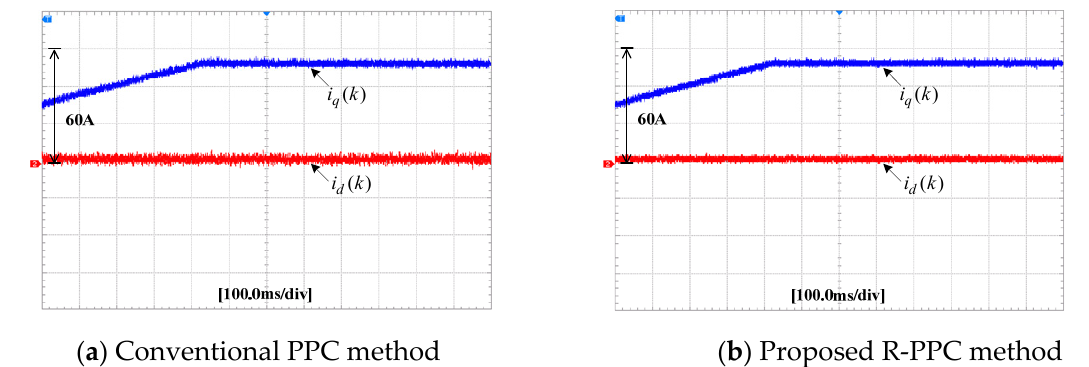
Figure 16. Experimental results of the d- and q-axis current under the charge state. ( a ) Conventional PPC method; ( b ) Proposed R-PPC method.